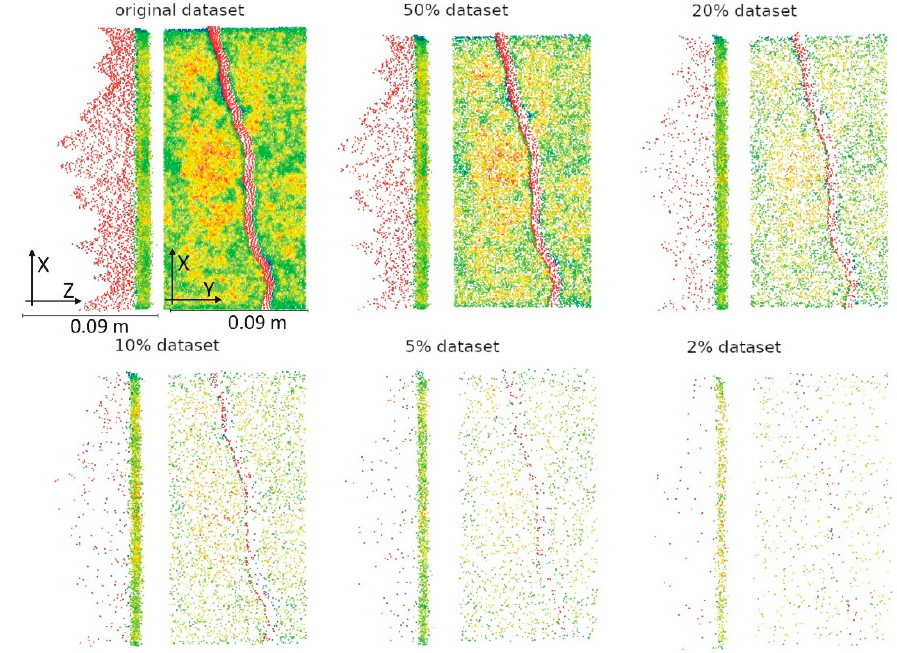
Figure 6. Damage mapping results in a concrete sample using the random method. Table 1. Results of processing with the OptD method—concrete sample.